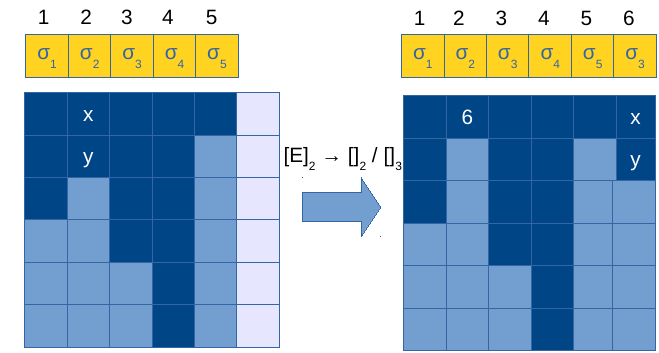
Figure 5. Illustration of application of a budding rule in the synapse matrix with compressed representation. Light blue cells in the synapse matrix are empty values (0), dark cells are positions with values greater than 0 (i.e., with neuron id), and light cells are empty columns allocated in memory (a total of q max ). Neuron 1 is applying budding, and its content is copied to an empty column (5) and replaced by a single synapse to the created neuron.